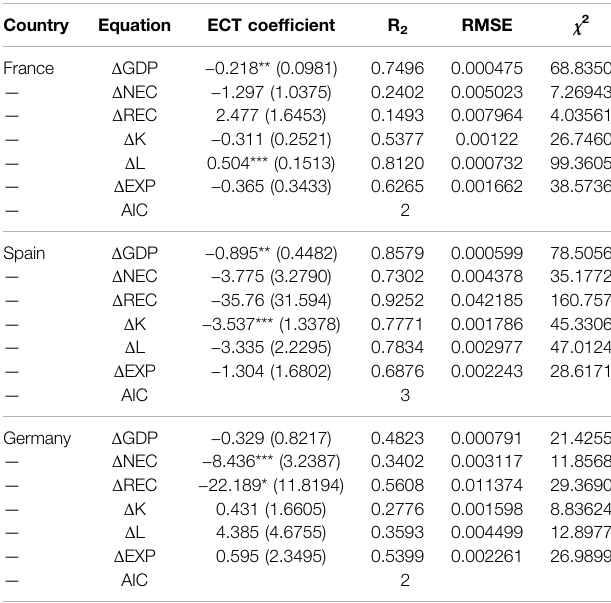
TABLE 10 | VECM estimation